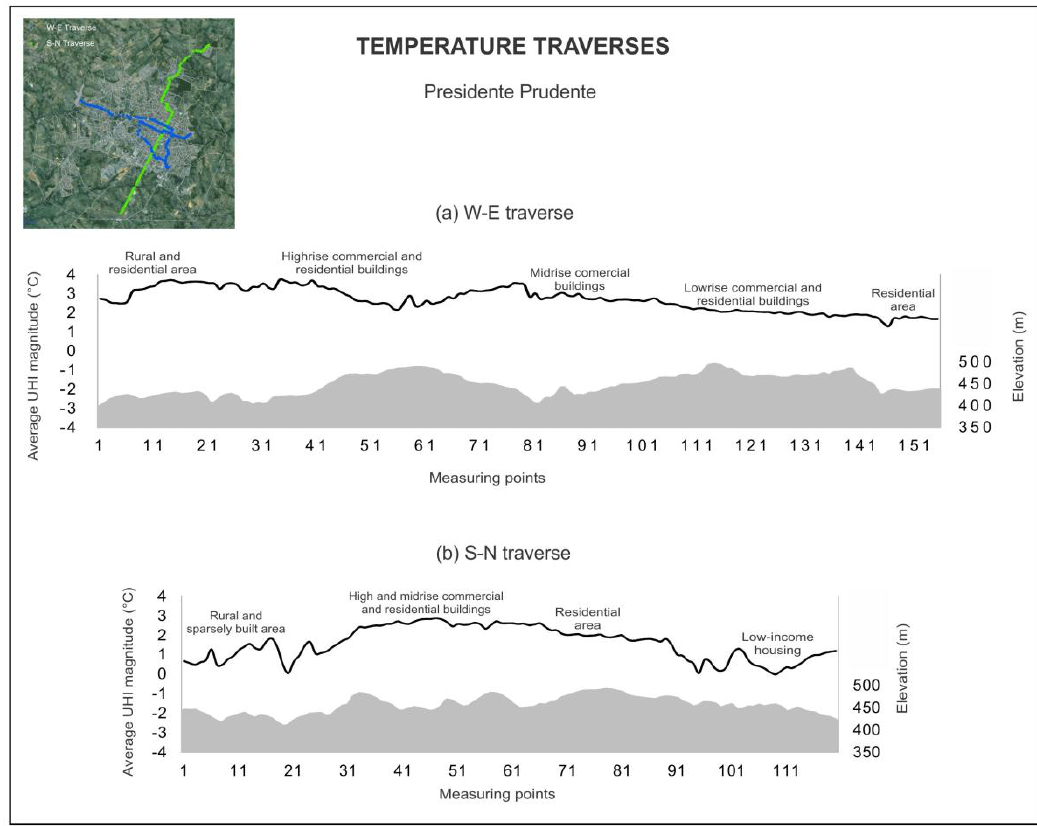
Figure 5. Summer average UHI magnitudes in Presidente Prudente during nighttime traverses, December 2013 (five nights): ( a ) west–east traverse; and ( b ) south–north traverse. Horizontal lines indicate the temperature profile. Surface relief is shown along the bottom axes.